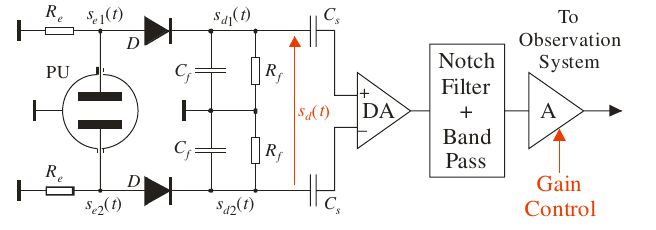
FIG. 5. (Color) Block diagram of a 3D AFE.